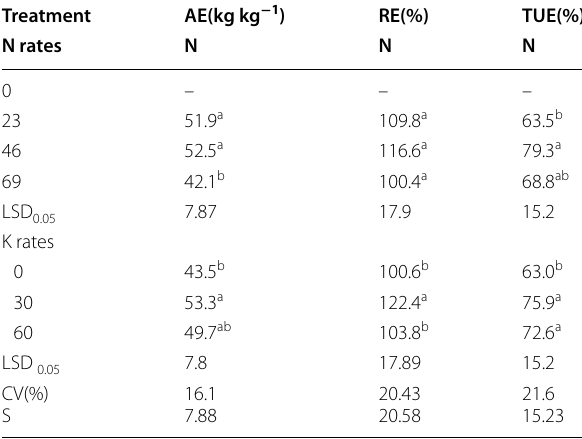
Table 7 Agronomic, crop recovery and TUE of N affected by the rate of N and K